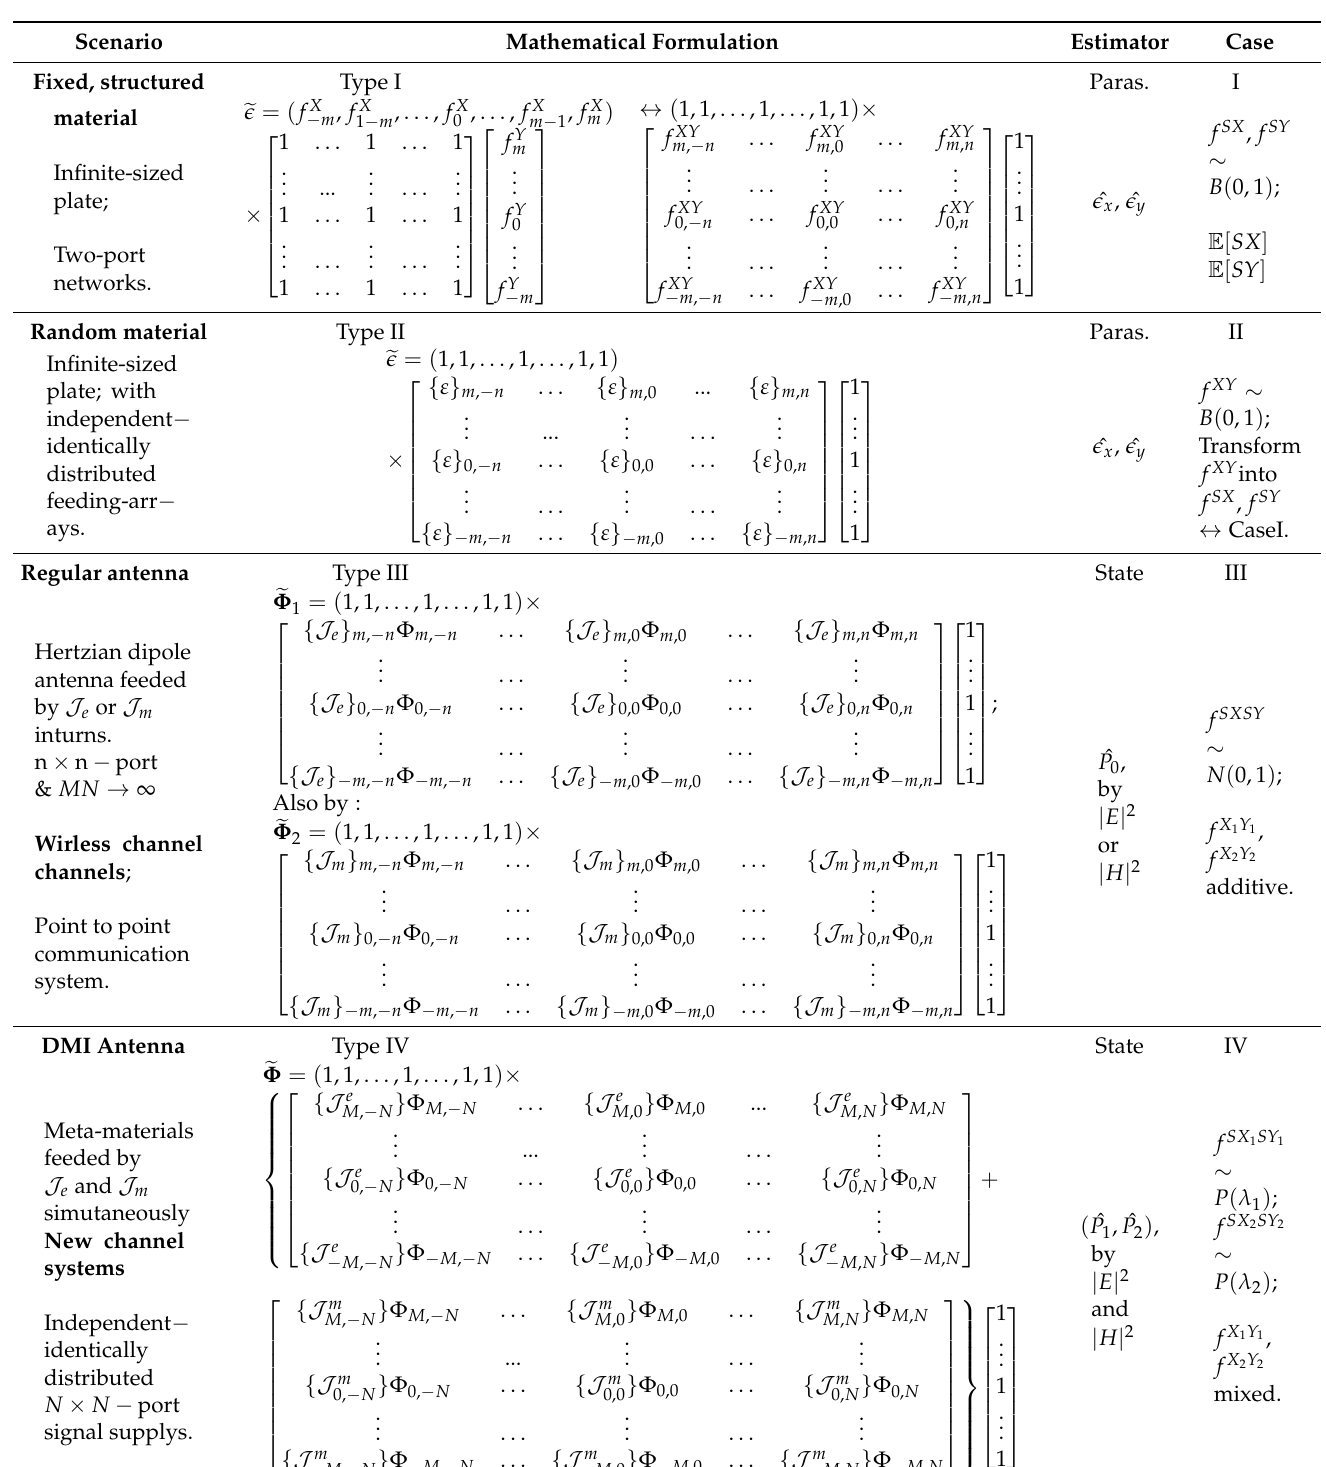
Table A1. Application Scenarios of